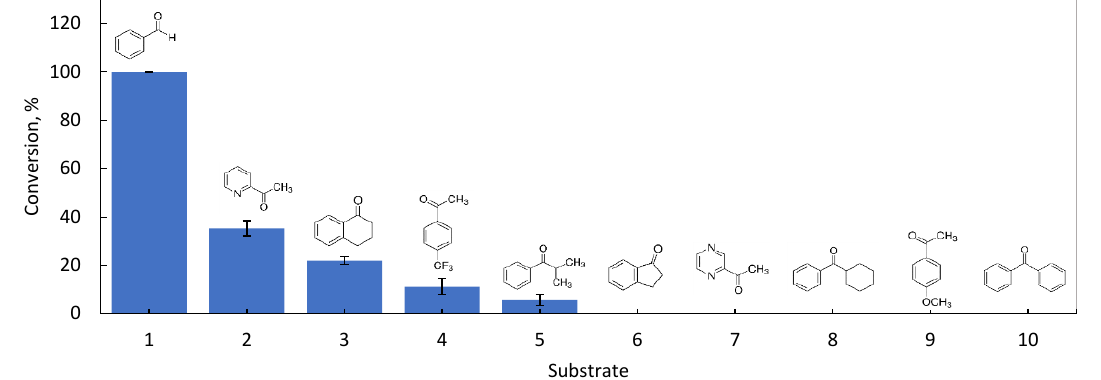
Figure 1. Conversion at 24 h of an aldehyde and nine different ketones by the marine bacterium G. arilaitensis 232. 1. benzaldehyde; 2. 2-acetylpyridine; 3. α -tetralone; 4. 4 (cid:48) -(trifluoromethyl)acetophenone; 5. isobutyrophenone; 6. 1-indanone; 7. 2-acetylpyrazine; 8. cyclohexyl phenyl ketone; 9. 4 (cid:48) methoxyacetophenone; and, 10. benzophenone. Results are the average of three independent bioconversions. Data are presented as mean ± standard